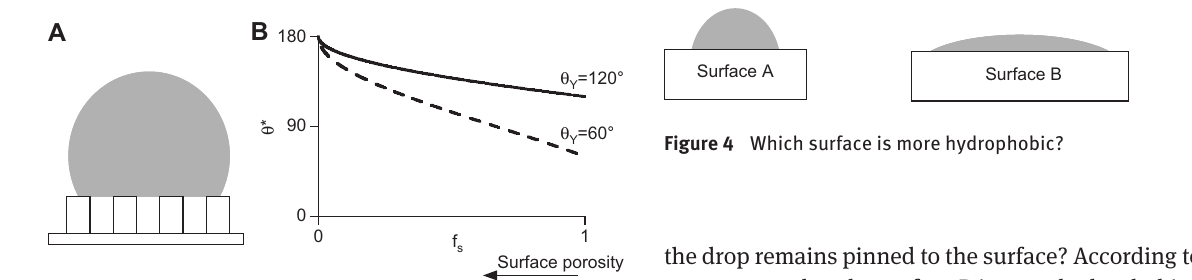
and receding θ A